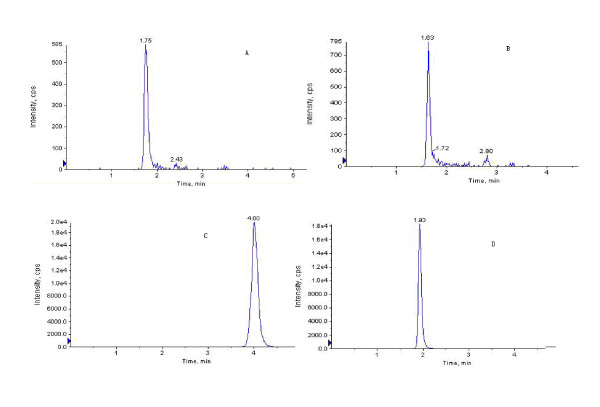
Chromatograms under LC/MS/MS conditions for analyzing beagle dog plasma sample 2 h after oral administration of bio-adhesive tablet of PNS at dose of 90 mg/Kg. Notoginsenoside R1 (A), Ginsenoside Rg1 (B), Ginsenoside Rb1 (C) and internal standard (D) were detected respectively. The retention time is 1.75 min for R1, 1.63 min for Rg1, 4.00 min for Rb1 and 1.93 min for I.S.